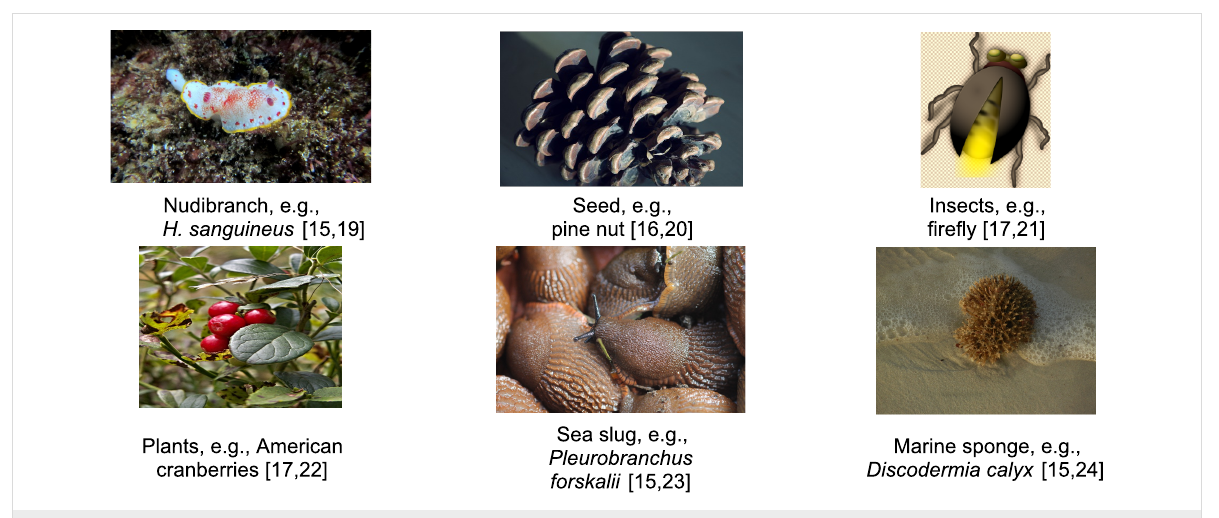
Figure 2: Some natural sources of